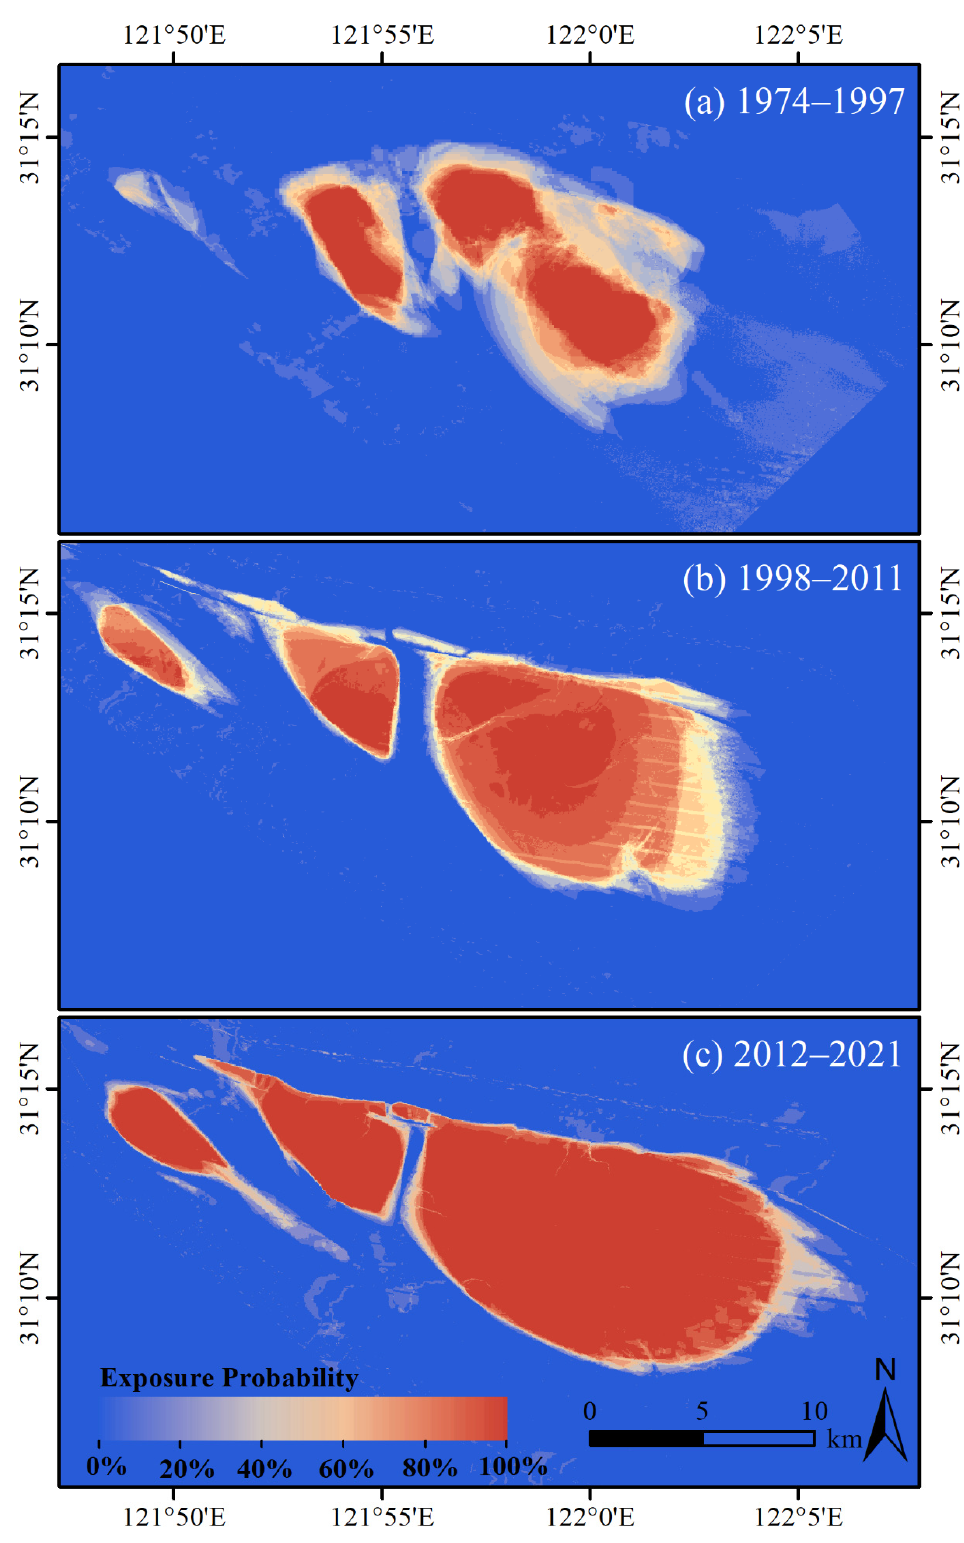
Figure 8. Exposure probability of the JDS in satellite images from ( a ) 1974–1997, ( b ) 1998–2011 and ( c ) 2012–2021.